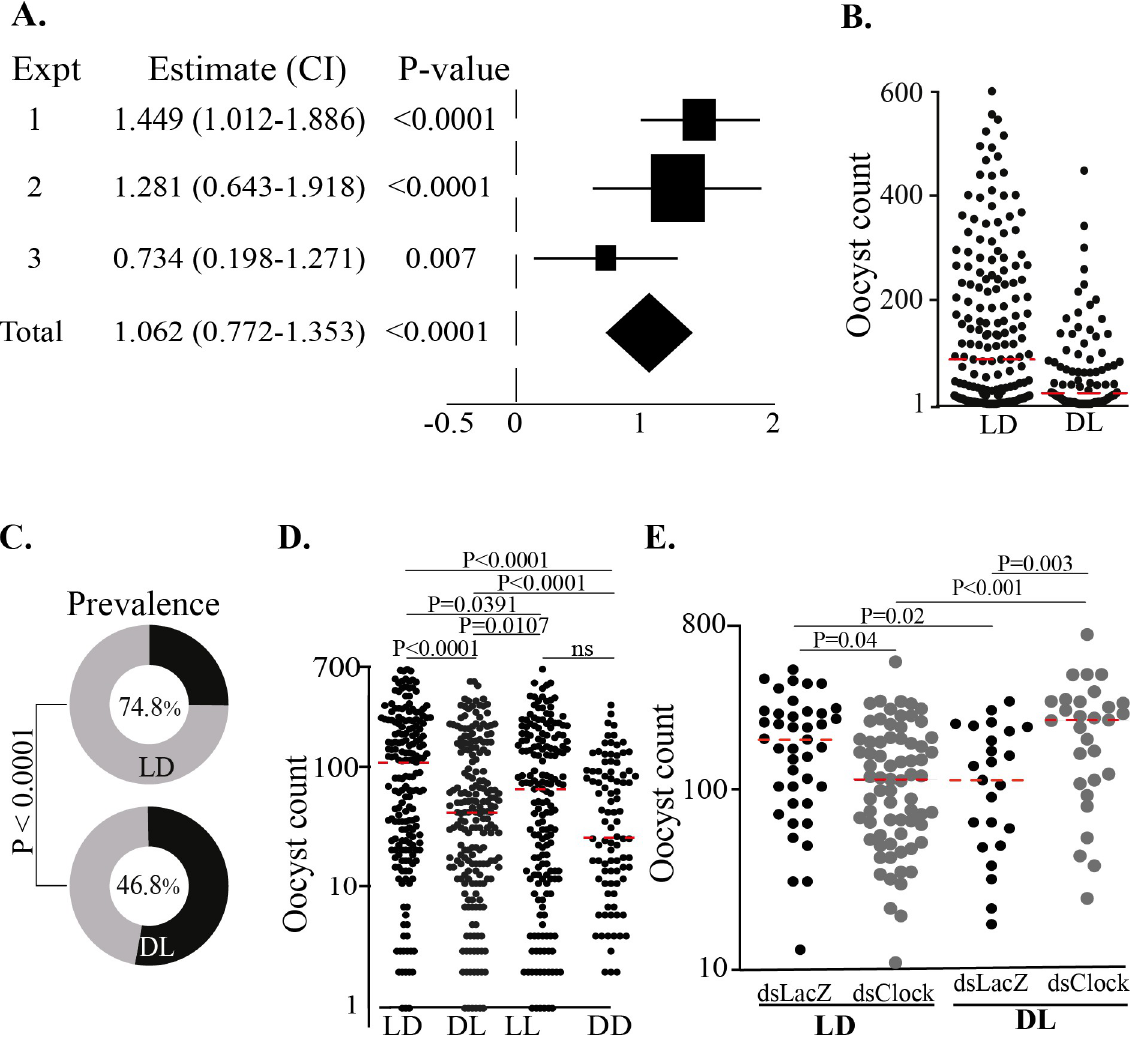
Fig 3. Mosquito circadian rhythm on the P . falciparum gametocyte infectivity. ( A ) Forest plot showing an estimate of effect ratio ( ± 95% CI) of oocyst intensities between mosquitoes under a LD regime and DL regimes; Squares and diamond show the sample size for each replicate and the total, respectively. ( B ) Overall oocyst intensities between mosquitoes under a LD and DL regimes; Red line represents the median. ( C ) Pie-charts showing oocyst infection prevalence in mosquitoes under LD and DL light-dark regime. The plots represent data from three independent replicates. ( D ) Oocyt intensity in the midguts of mosquitoes reared and maintanied under differnet light/dark regime: (LD) the standard insectary ligh (12h)/dark (12h), (DL) reversed dark/light regime, (LL) constant light or (DD) constant dark. ( E ) Effect of CLOCK gene silencing on the oocyst intensity in mosquitoes under normal and reversed light/dark cycle. Red lines represent the median. gametocytes during the natural foraging hours of the mosquito [29, 46, 47] and in the Plasmo- dium relictum and Culex pipiens system, increased mosquito infection was reported in the late afternoon, which coincides with natural biting hours of the vector [48], suggesting that vector daily rhythms have a role in shaping the interactions between the vector and Plasmodium para- site. Studies have shown that a considerable proportion ( > 20%) of A . gambiae genes have rhythmic expression, including immunity-related genes such as those encoding regulators of the IMD pathway and immune effectors including defensin 1 ( DEF1 ), cecropin 1 ( CEC1 ) and nitric oxide synthase ( NOS ) [28], which may therefore contribute to the differential infection susceptibility of mosquitoes across the diel cycle [18, 27].